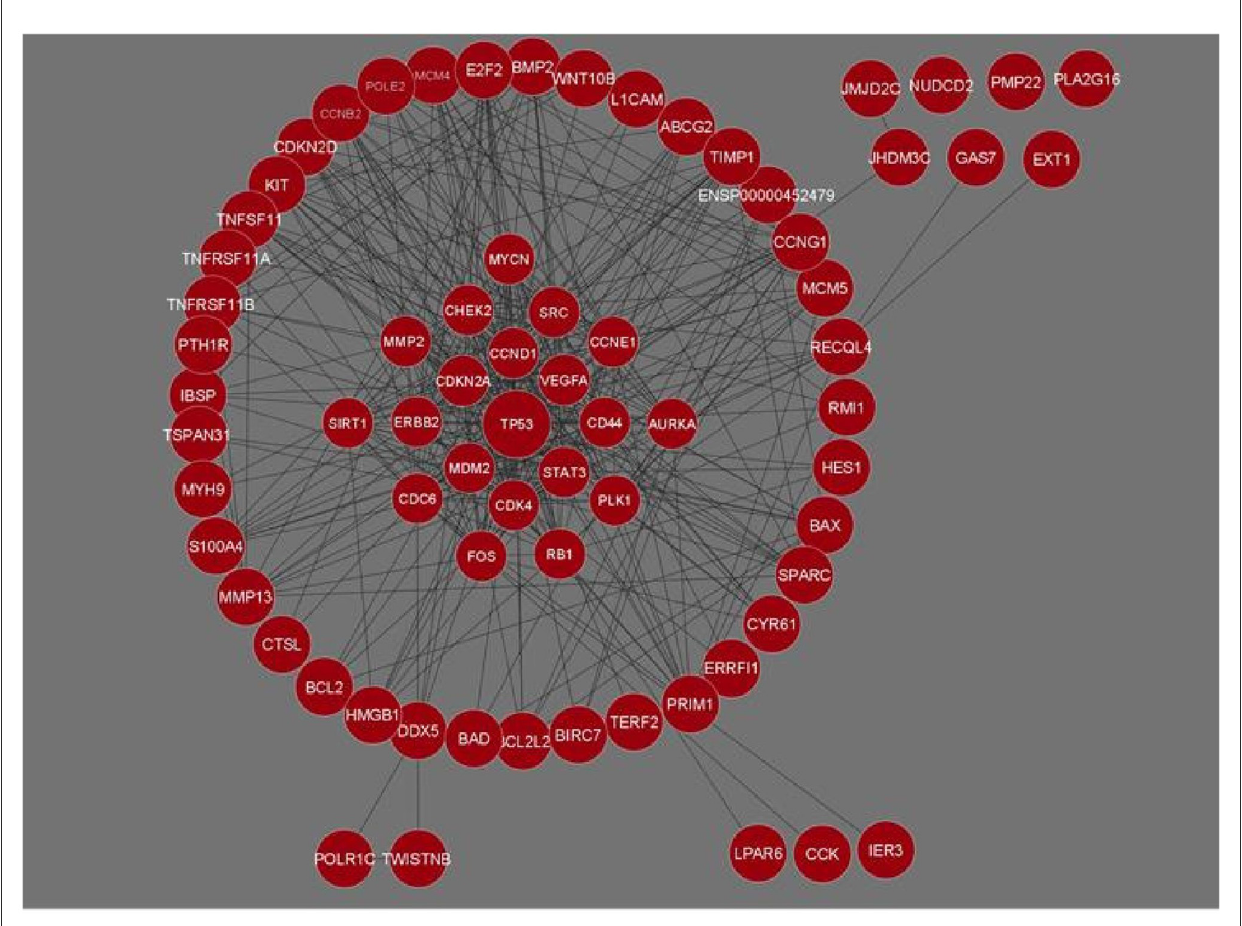
FIGURE1 Gene interaction network of Osteosarcoma comprising 71 genes and 426 interactions built in Cytoscape. Genes with the maximum number of network interactions are positioned in the center (ENSP00000452479 is the Ensembl protein ID for sequence BCL2L2-PABPN1).